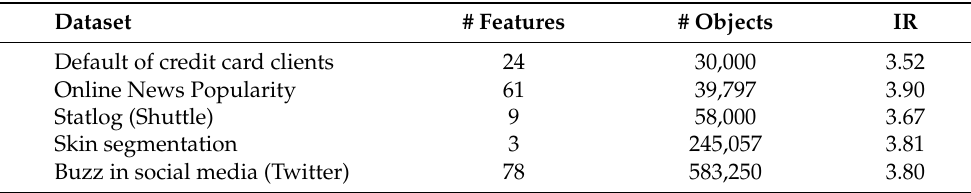
Table 5. Large datasets from the UCI repository used in our experiments.